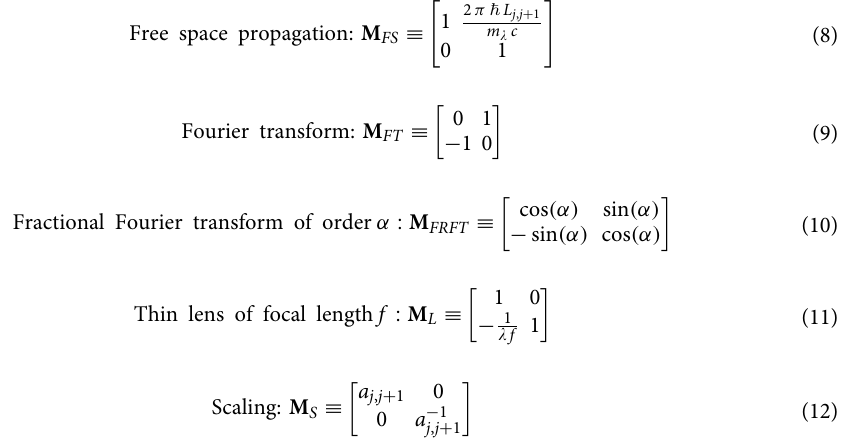
Figure 3. Photonic QPC architecture composed of classical light source, MPD set-up composed of N diffraction planes with K j slits on j th plane, general LCT phase-space optics represented with the matrix elements LCT j , j 1 between the planes indexed with j and j + increasing number of propagation paths interfere. Each LCT j , j lengths of L a , j , j 1 and L b , j , j 1 , and a thin lens of focal length f j , j + +